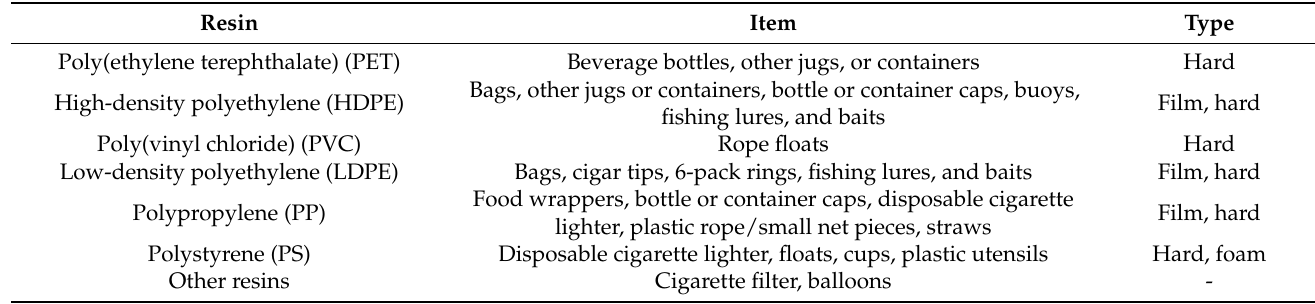
Table 1. Macroplastics’ classification, adapted from Lippiatt, Opfer, and Arthur [26].